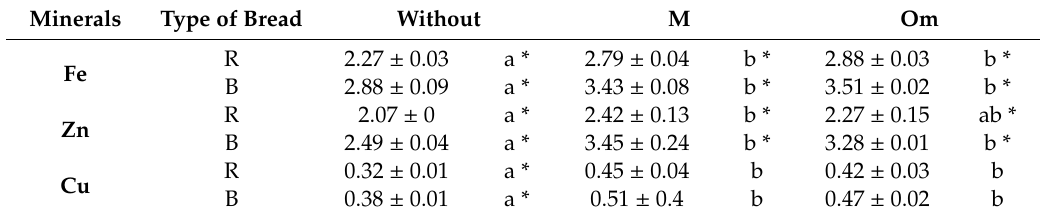
Table 2. Content of minerals in diets with gluten free breads [mg / 100 g]. Minerals Type of Bread Without M Om